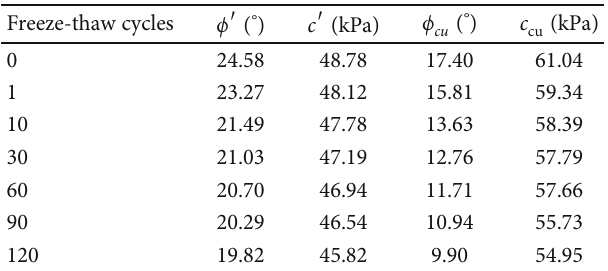
Table 7: Undrained shear strength index of specimens under di ff erent numbers of freeze-thaw